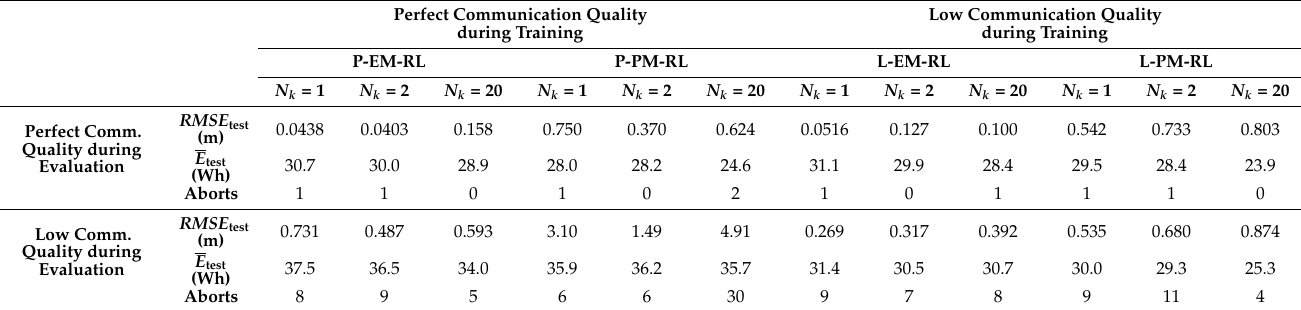
Table 2. Results of trained agents for the driving cycle test set during both perfect and low communication quality. The test set consisted of 93